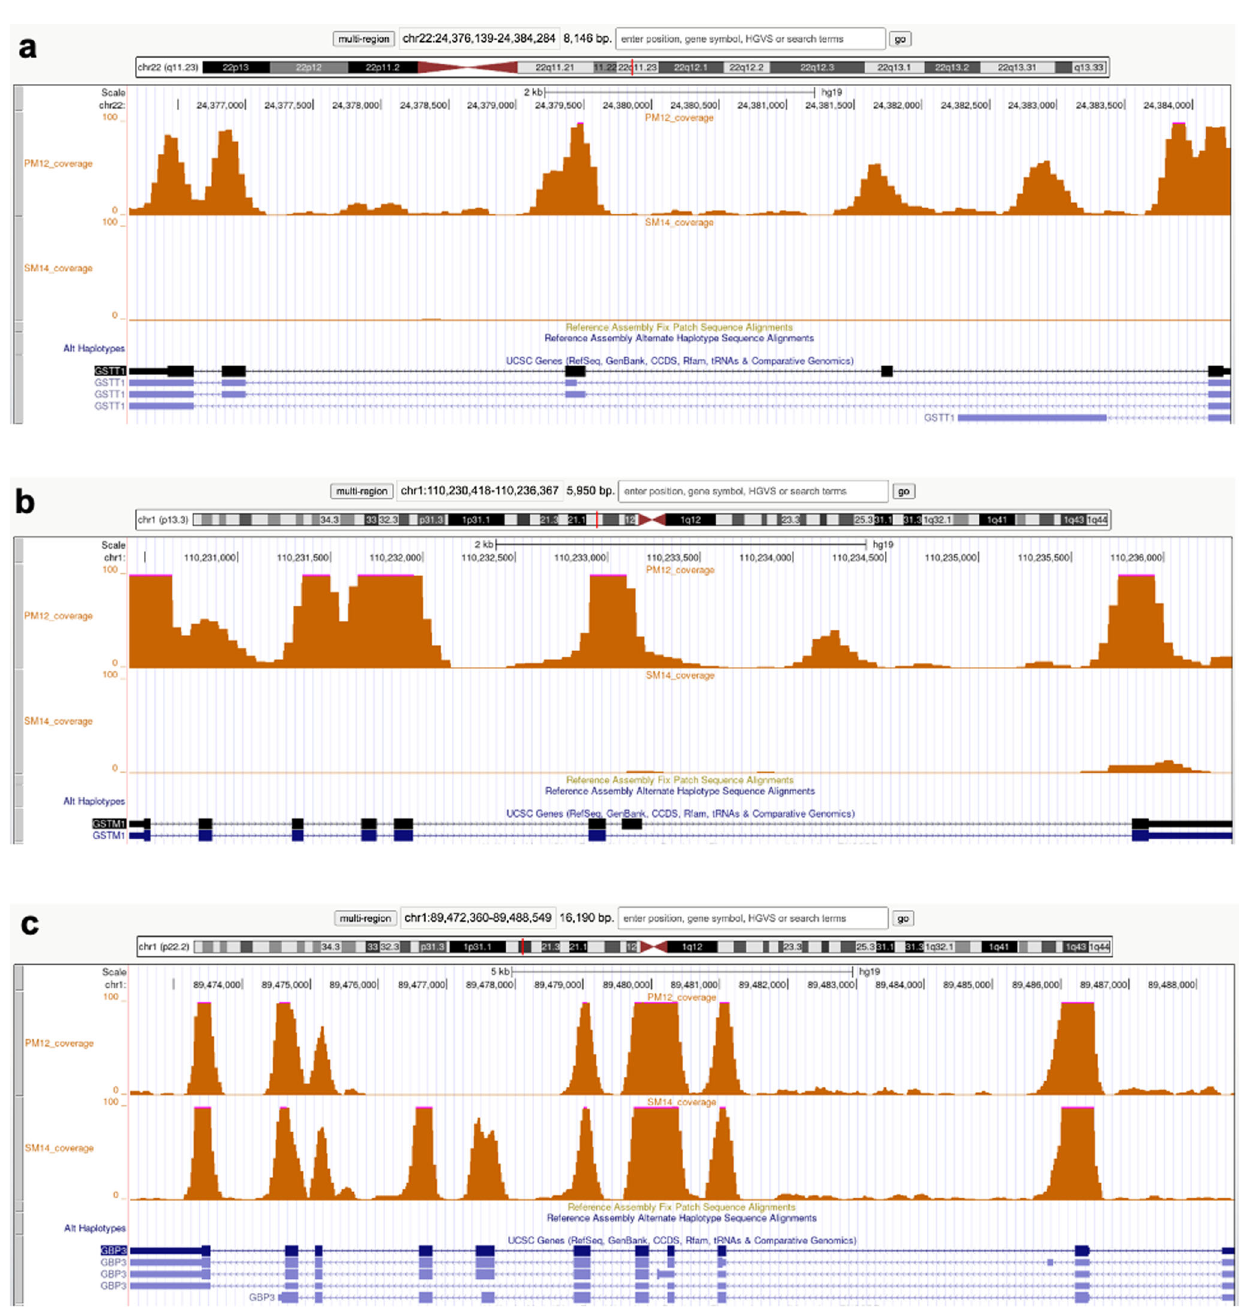
Fig. 4 Large copy number variants. a , b UCSC genome browser (Hg38) visualizing the coverage for the hiPSC lines PM12 and SM14 from whole exome sequencing with orange peaks that align with the locations of exons. SM is missing both copies of the GSTT1 ( a ) and GSTM1 b genes. c PM is missing coverage across exons 7 and 8 in GBP3